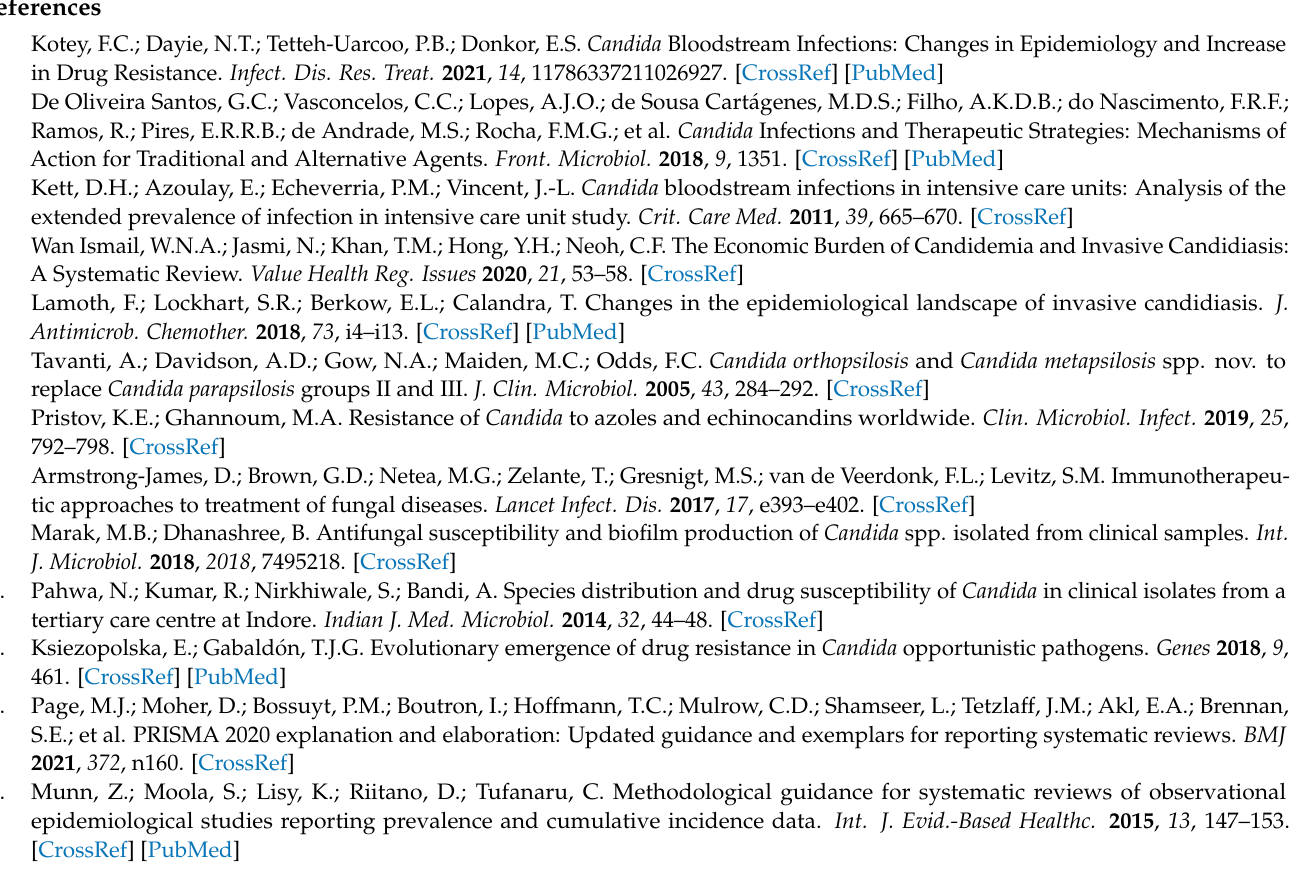
Table S4: Quality assessment of the included